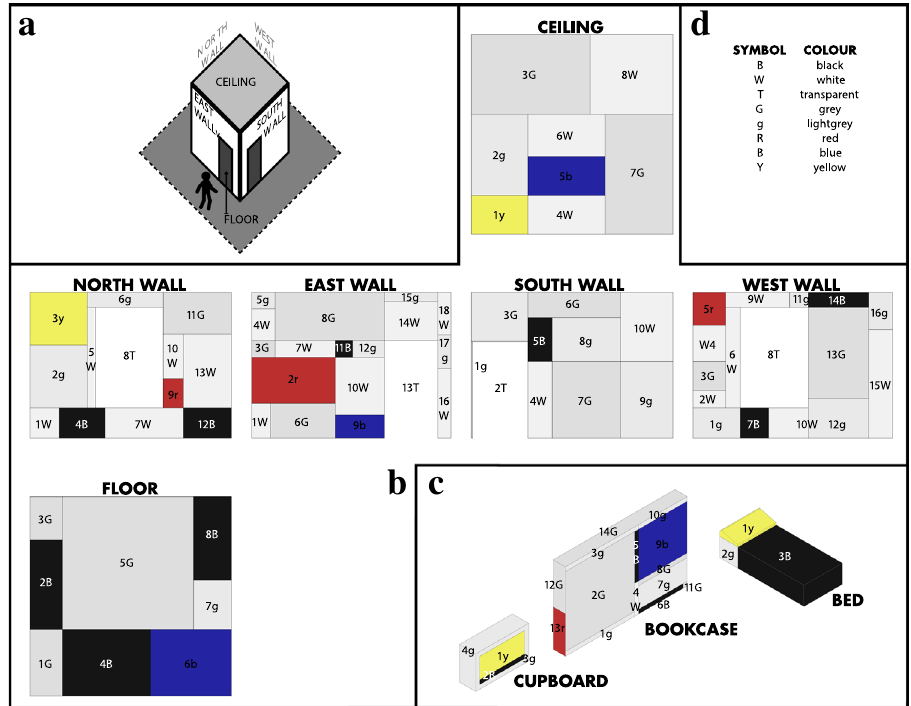
Figure 2. An overview of 3D AOI mapping for the VR condition. ( a ) A diagrammatic view of the cuboid room, in which ( b ) six surfaces of the room and ( c ) three pieces of furniture were present. Each individual coloured 2D panel was coded as an individual AOI during the development of the VR environment, and ( d ) had a unique colour value out of six possible colours. For example, the dwell time on red colour patches was calculated as the cumulative sum of fixation duration on four AOIs, namely North-9r, East-2r, West-5r, and Bookcase-13r. Along the same lines, the 3D AOI mapping was also formed for the physical condition, regarding the same sets of